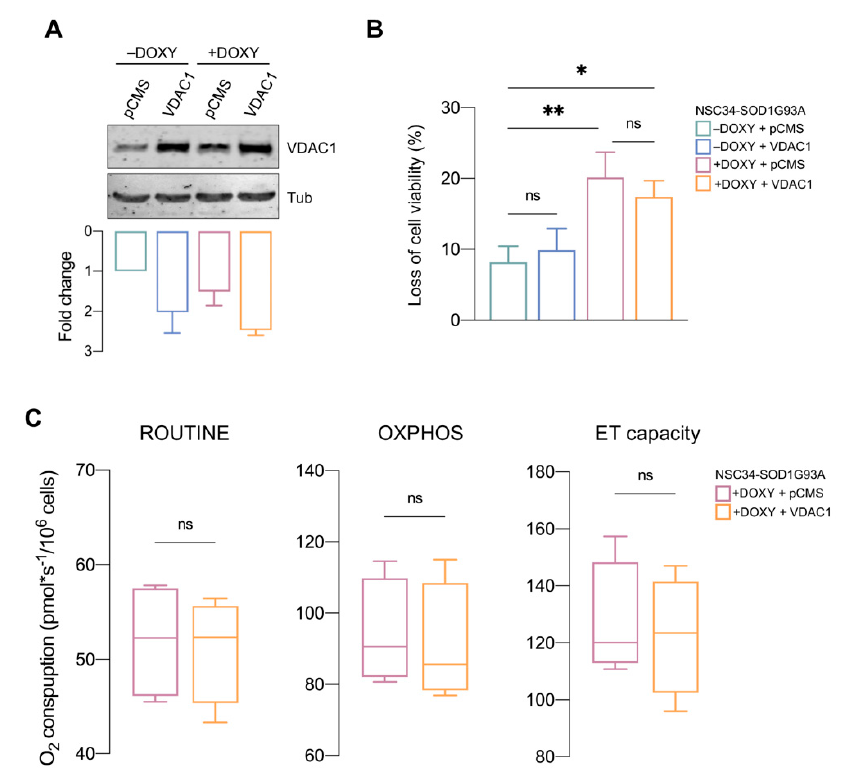
Figure 5. VDAC1 overexpression does not support the mitochondrial bioenergetic of NSC34- SOD1G93A cells. ( A ) Representative Western blot images of total lysates from +/ − DOXY NSC34- SOD1G93A transfected with empty plasmid pCMS or plasmid carrying VDAC1, and the relative quantification. Tubulin was used as loading control. ( B ) Cell viability assay of +/ − DOXY NSC34- SOD1G93A transfected as in A. Data are expressed as median ± SD of n = 3 independent experiments and analyzed by one-way ANOVA. Values of * p < 0.05 and ** p < 0.01 were taken as significant. ( C ) Quantitative analysis of the oxygen consumption in intact (ROUTINE) or permeabilized cells (OXPHOS and ET capacity) of +DOXY NSC34-SOD1G93A cells transfected with empty plasmid pCMS or plasmid carrying VDAC1. Data are expressed as median ± SD of n = 4 independent experiments and analyzed by t -test; ns, not significant.